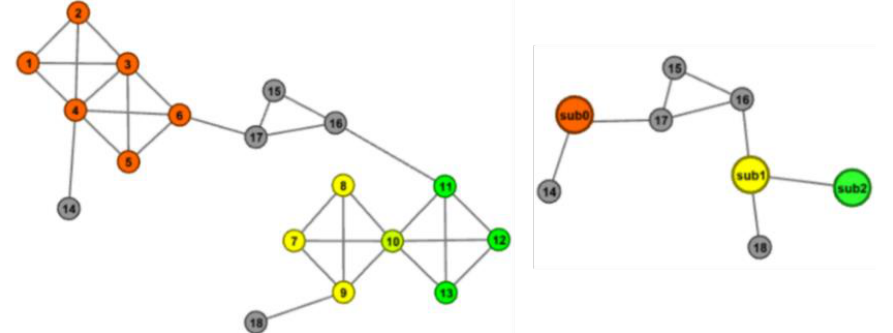
Figure 4. Example of folding a network.